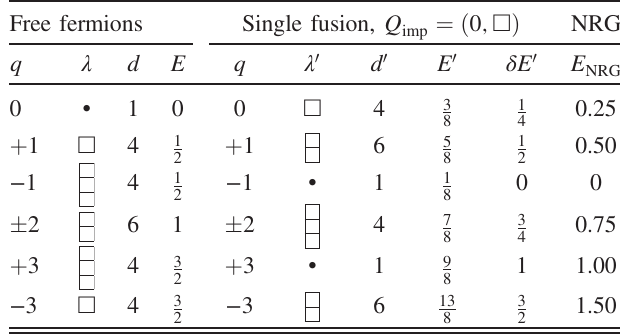
TABLE VI. Fusion table for the FL fixed point of the SU(4) Kondo model. It is structured just as Table IV for the SU(6) Kondo model, but here the free bath excitations are computed using Eqs. (A2) and Table S8 of the SM [54], and flavor fusion is performed using SU ð 4 Þ 1 fusion rules (Table S9 of the SM [54]). The NRG spectrum was computed for the 2soK model with NRG spectra agree very well (deviations ≲ 1%